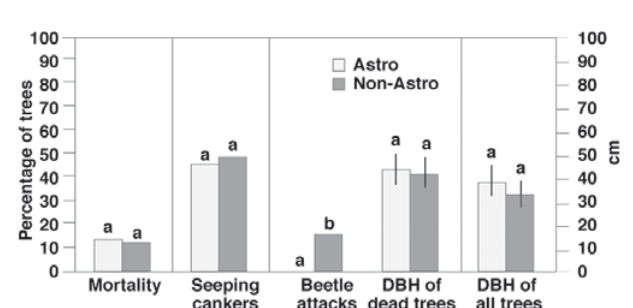
Fig. 2. Two adjacent sites in a forest stands have com- parable oak populations as exemplified by the DBH (di- ameter at breast height). Each site contained 67 oaks. In the site treated with the permetrhine insecticide As- tro, only beetle attacks were controlled, while mortality rate and bleeding caused by Phytophthora ramorum re- mained unchanged. These data showed beetles were not the causal agent of SOD. (Printed from California Agri- culture 55(1), 9–18, 2001, by permission of the Regents of the University of California, CA,